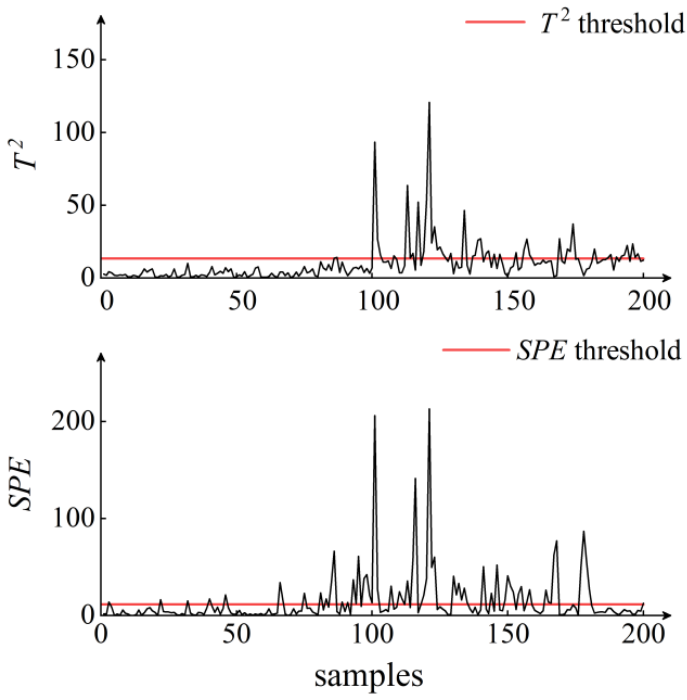
Figure 8. PLS monitoring of sample 1.